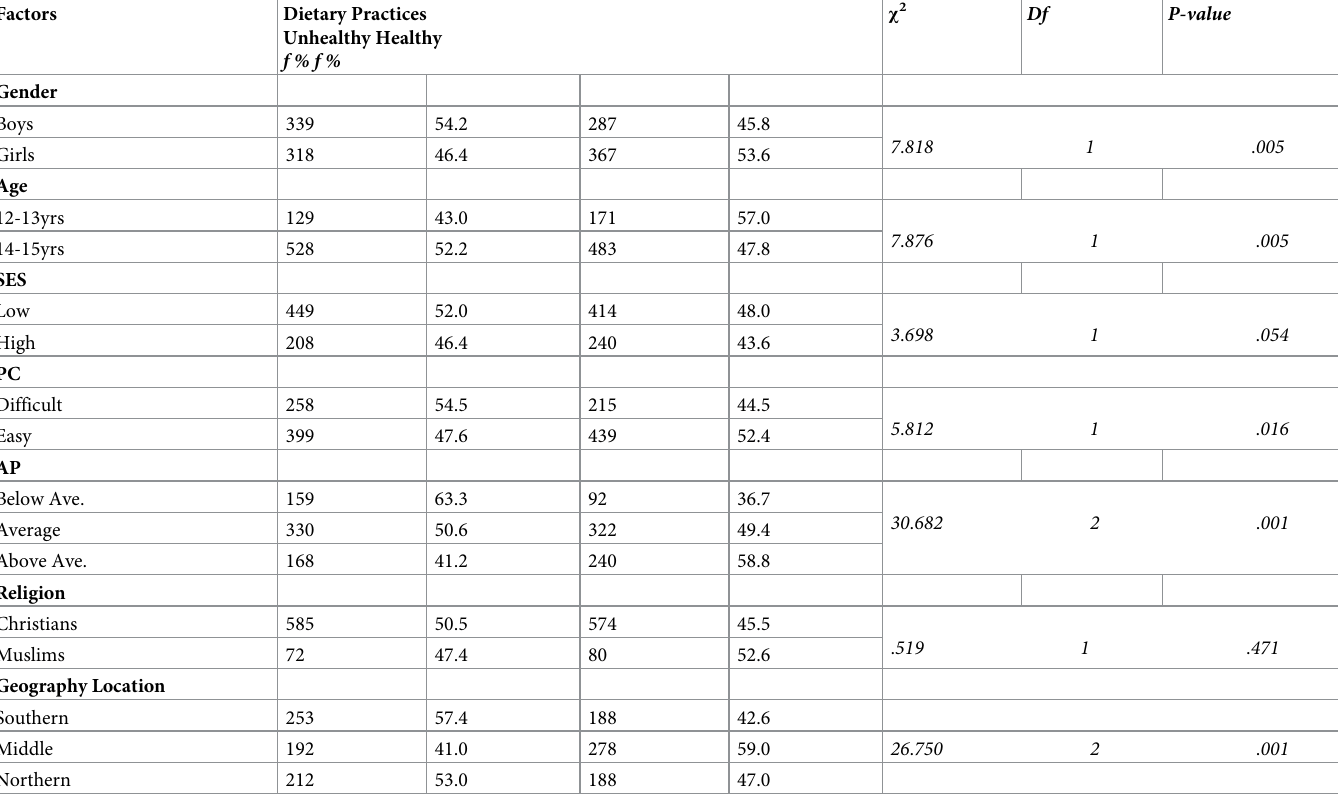
Table 2. Sociodemographic variations in the dietary